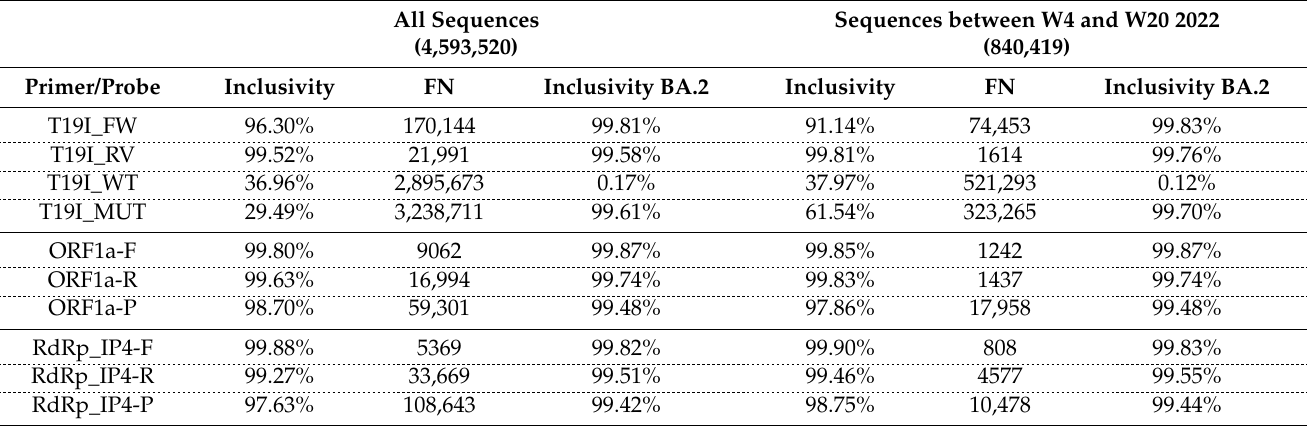
Table 3. Inclusivity in silico evaluation of T19I, ORF1a, and RdRp assays. For the two datasets, all sequences and sequences after 1 December 2021 were evaluated in silico for the T19I, ORF1a, and RdRp assays. The inclusivity shows the percentage of genomes that perfectly matched the primer or probe. Moreover, this was calculated for only the genomes belonging to the BA.2 lineage. The false negatives (FN) are the number of genomes that did not perfectly match with the primer or probe.